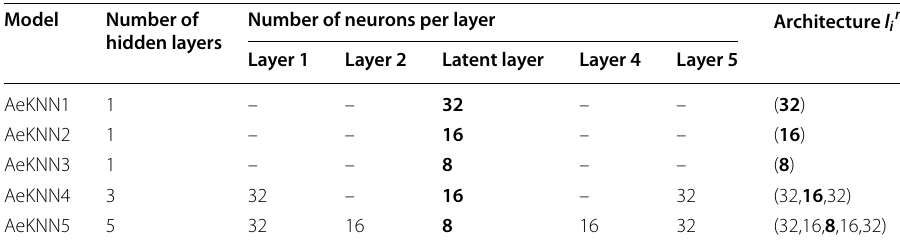
Table 2 Experimental configurations of AeKNN Model